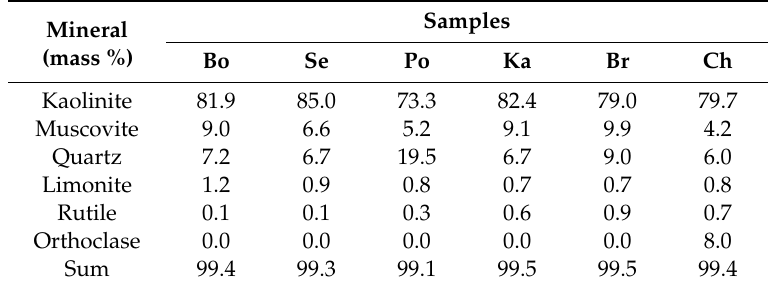
Table 5. Quantitative amounts of minerals in kaolin samples determined using CQMA method.